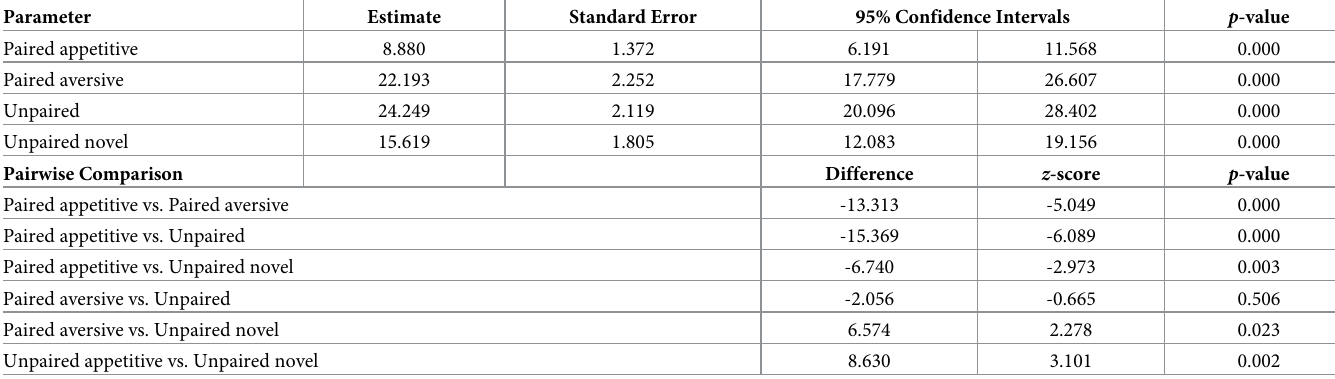
Table 6. Experiment 1 preference MPR